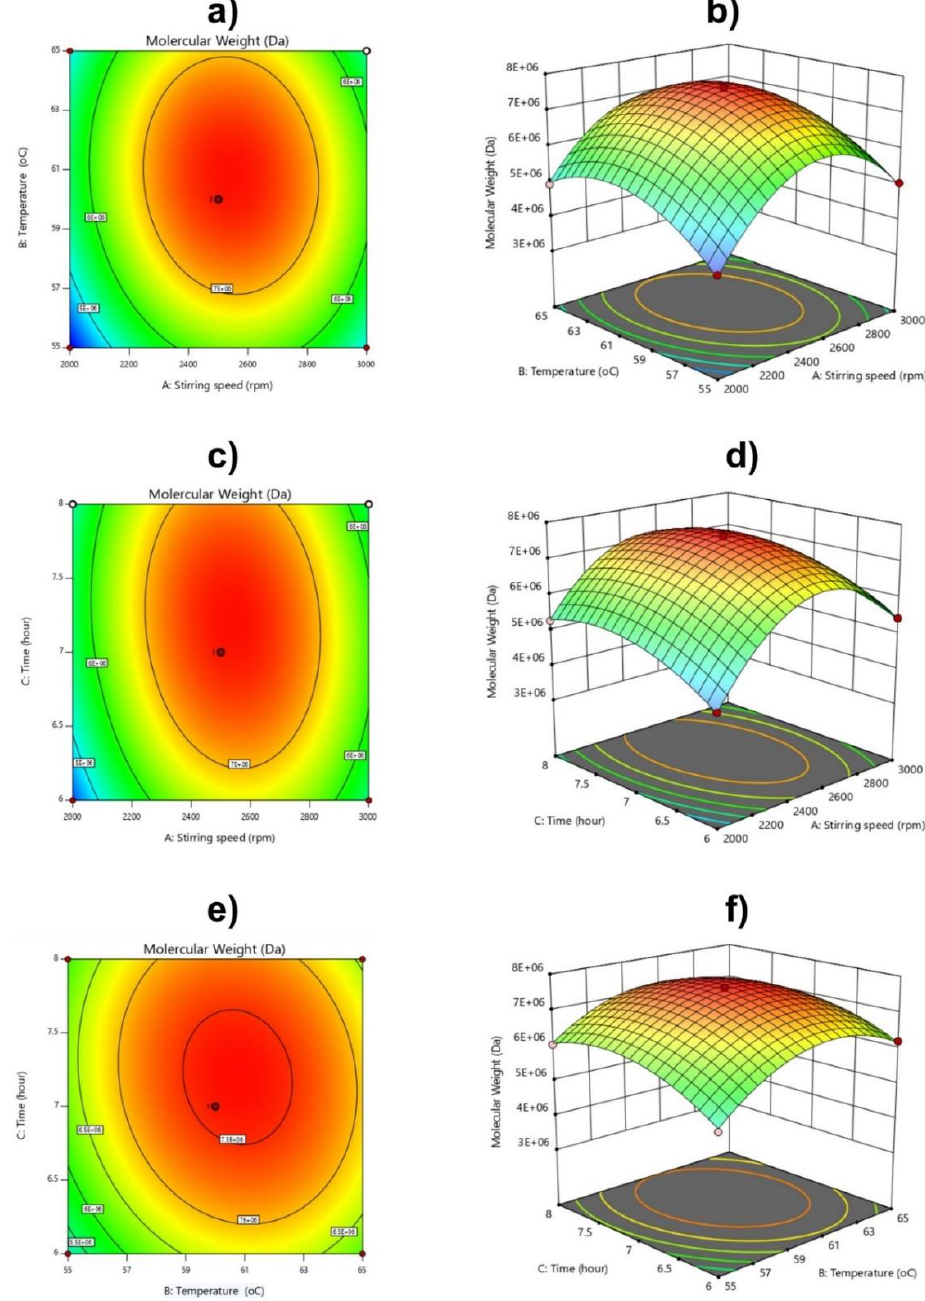
Figure 10. 2D contour graphs and 3D response surface: Analysis of interaction effect ( a , b ) of stirring speed and temperature, ( c , d ) stirring speed and time, and ( e , f ) temperature and time on Molecular Weight.